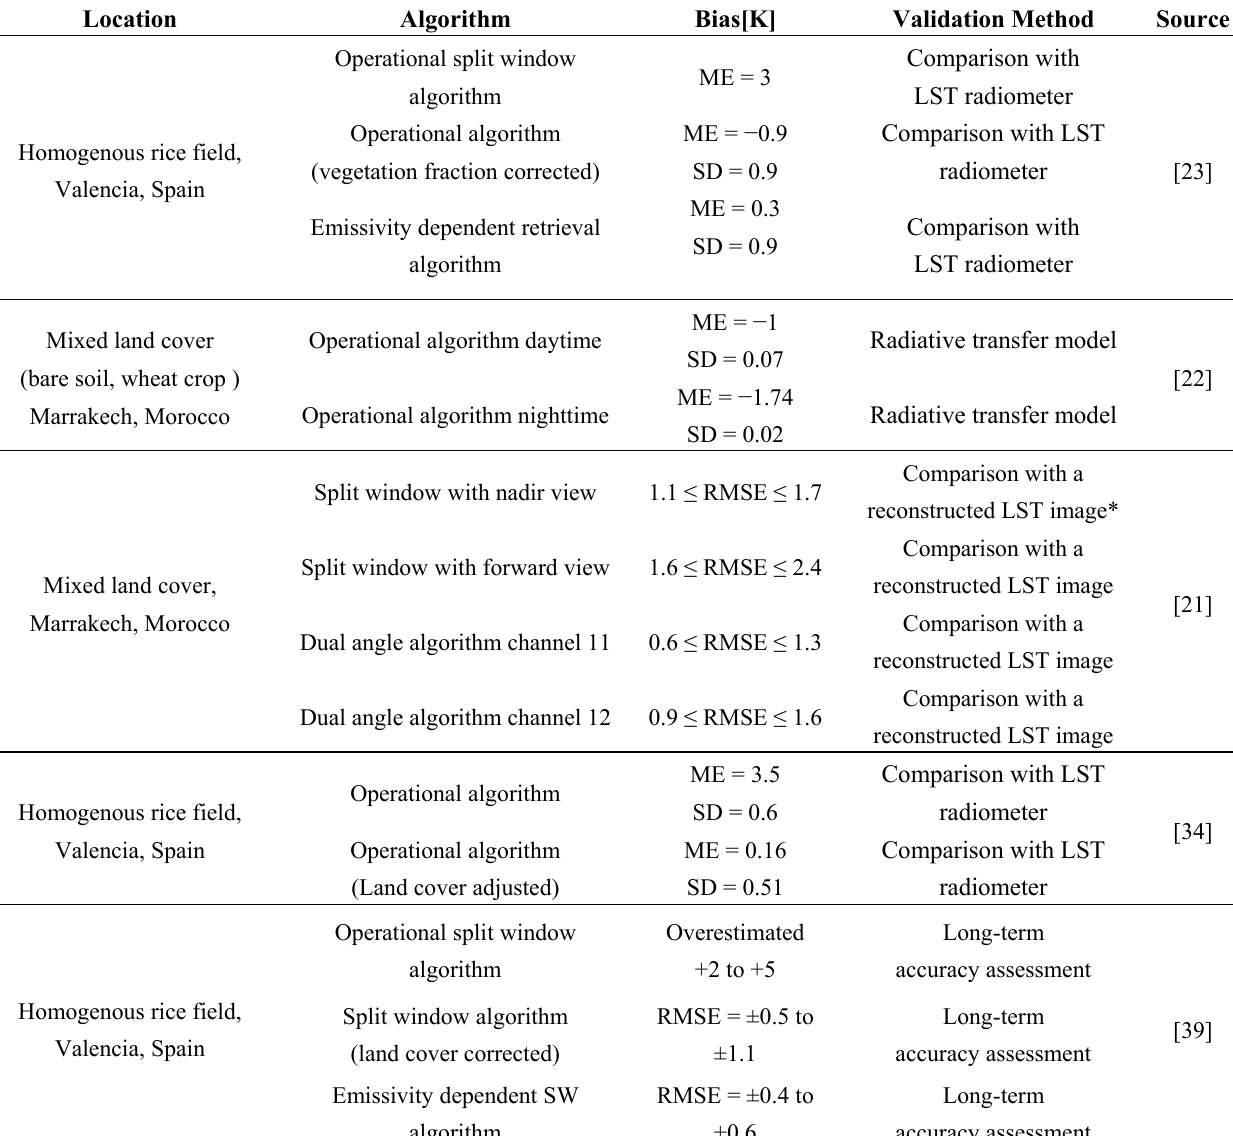
Table 2. Summary of accuracy assessment of L2 AATSR LST products using different retrieval